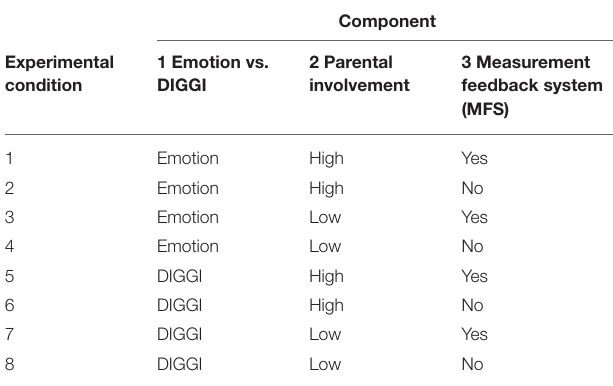
TABLE 1 | Components and experimental conditions in the ECHO